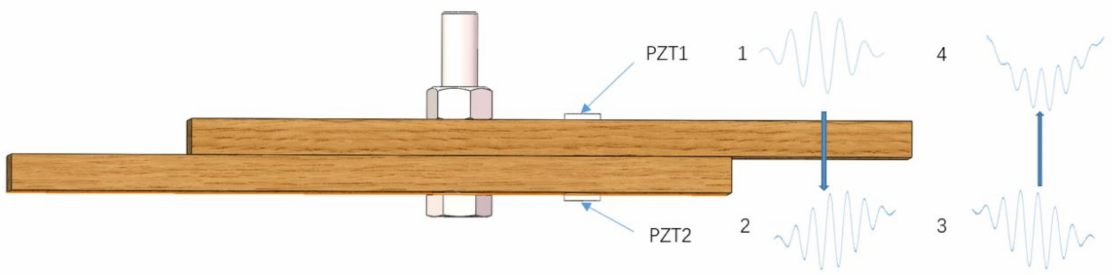
Figure 2. Experimental sample and method